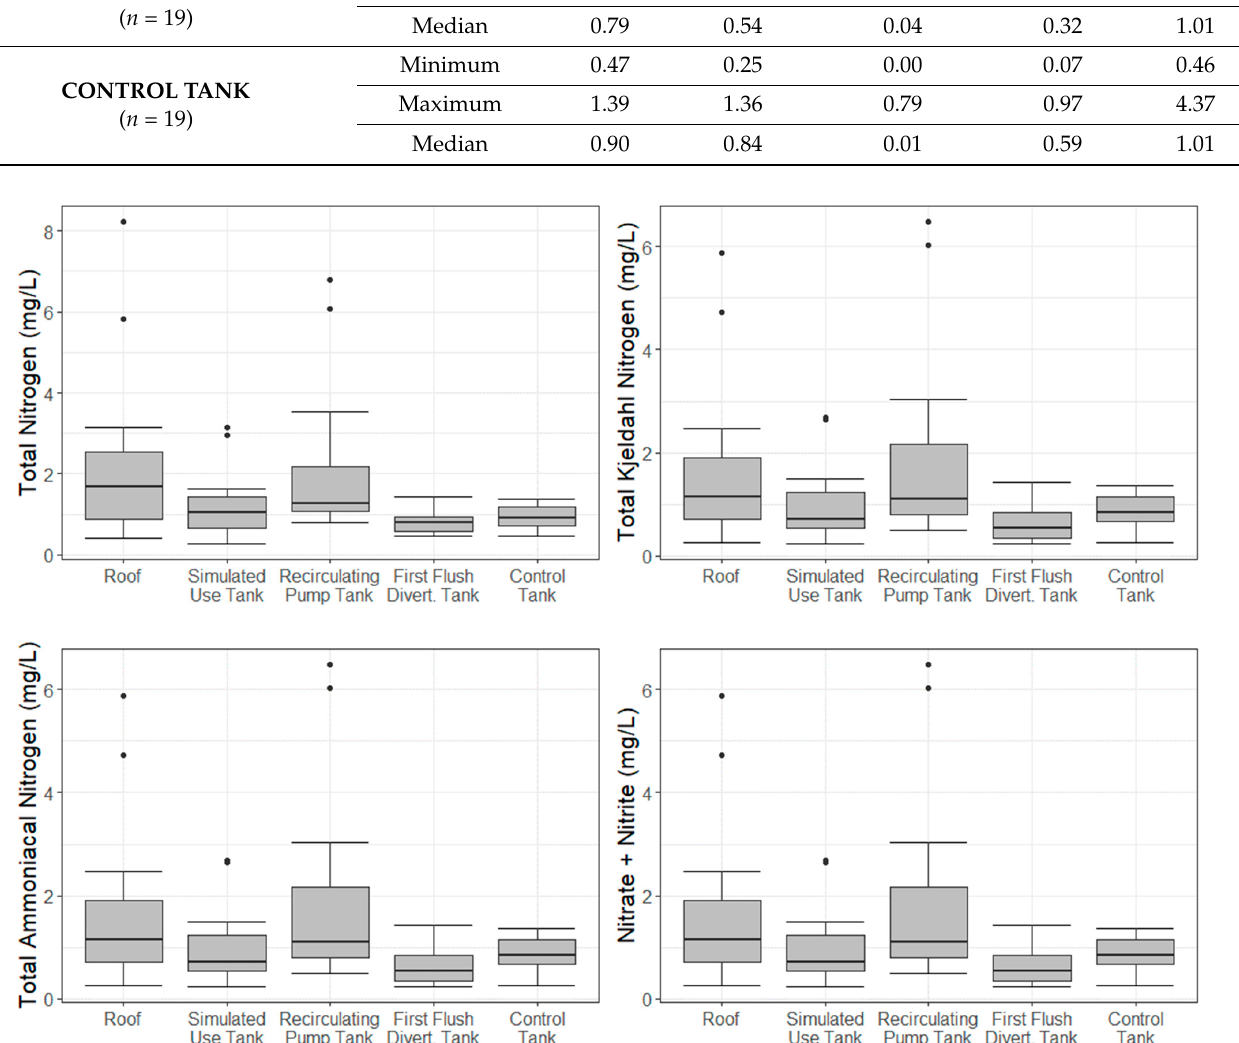
Figure 5. Total nitrogen, total Kjeldahl nitrogen, total ammoniacal nitrogen, and nitrate + nitrite nitrogen concentrations for roof runoff and rainwater tank samples. Black dots represent outliers (defined as values greater than or less than 1.5 * inner quartile range).